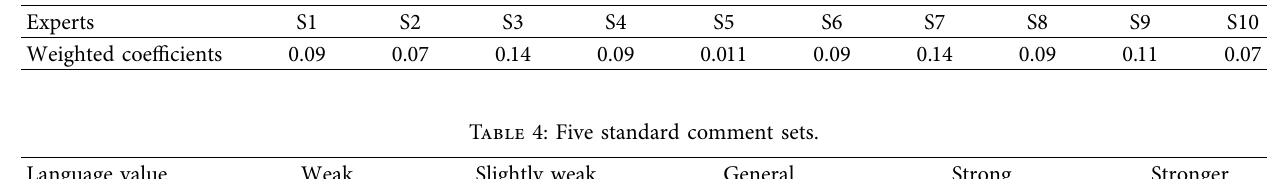
Table 3: Expert rating weighted coefficients.